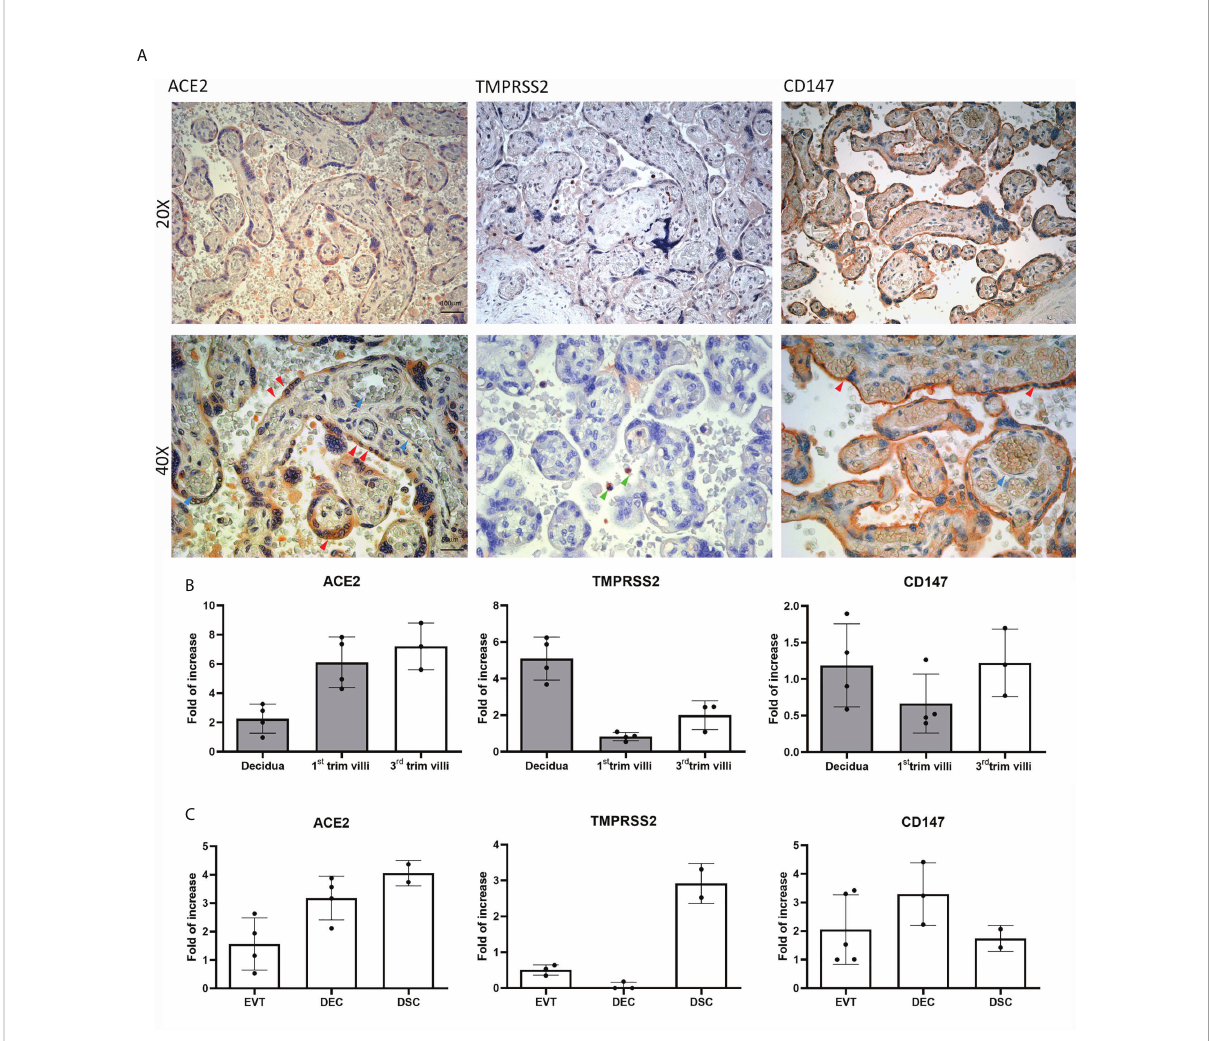
FIGURE 1 Distribution and basal expression of the SARS-CoV-2 receptors in healthy placentae. (A) Representative microphotographs showing ACE2, TMPRSS2 and CD147 distribution in placental tissues. ACE2 was localized within syncytiotrophoblasts, whilst TMPRSS2 staining was almost negative. Staining for CD147 indicated a high protein expression. AEC chromogen (red) was used to visualize the binding of anti-human primary antibodies. Red arrows indicate syncytiotrophoblast, blue arrows villous vessels and green arrows show leukocytes in the intervillous space. Nuclei were counterstained in blue with Mayer's Hematoxylin; scale bars, 100 µm. (B) Analysis of mRNA expression of SARS-CoV-2 receptors in placental tissues derived from healthy placentae: 5 from fi rst trimester (grey histograms) and 3 from third trimester placentae. Data are represented as mean ± SE of three independent experiments performed in triplicate. (C) Histograms representing ACE2 , TMPRSS2 and CD147 mRNA expression in extravillous trophoblast (EVT), endothelial (DEC) and stromal (DSC) cells isolated from normal fi rst trimester decidua. Data are represented as mean ± SE of three independent experiments performed in